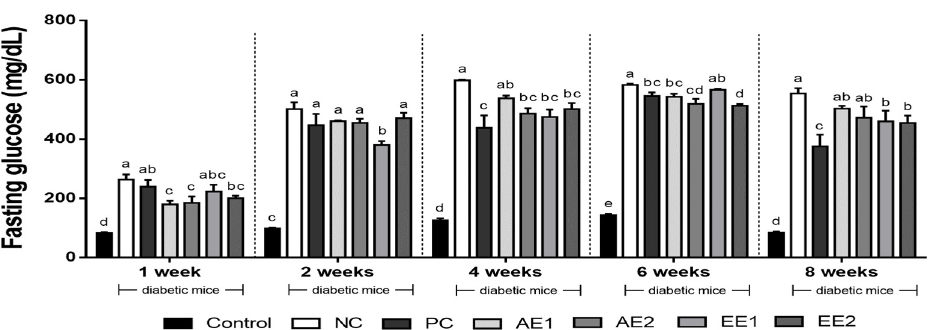
Figure 2. Effects of A. hookeri extracts on fasting blood glucose levels in the diabetic mice. Control: non-diabetic mice; NC: negative control; PC: positive control, metformin 150 mg/kg BW; AE1: aqueous extract 100 mg/kg BW; AE2: aqueous extract 200 mg/kg BW; EE1: ethanol extract 100 mg/kg BW; EE2: ethanol extract 200 mg/kg BW. AE and EE groups were treated with A. hookeri extracts for 8 weeks. Data are presented as the mean ± SEM (n = 8). a–e Mean values with different letters are significantly different at p < 0.05.